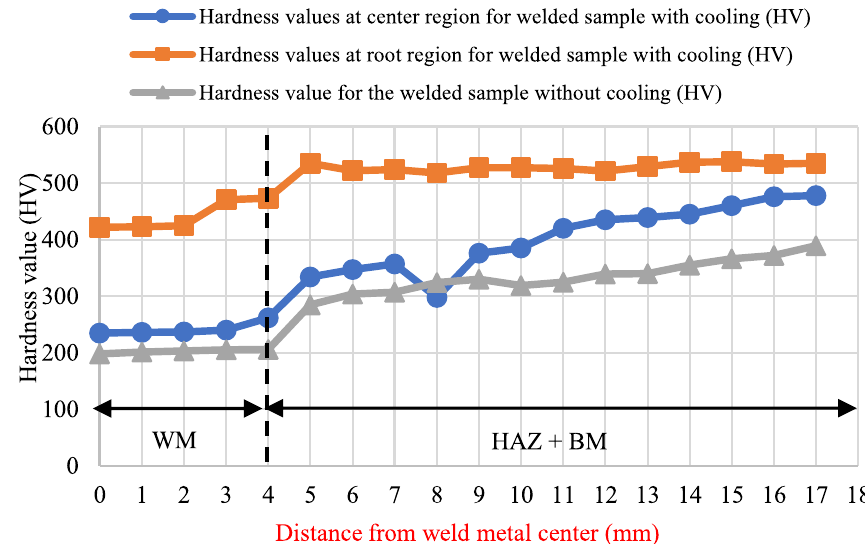
Table 14 and Fig. 18 show the hardness distribution of the joint welded using AWS A5.9 ER 307 filler wire and applying a single bevel groove joint. Without cooling, the hardness distribution at the mid-depth of the cross section of the specimen shows an increase in the hardness values that occurred in the HAZ with a sudden decrease in the hardness at the base metal region. Application of cooling resulted in the sig- nificant retainment of base metal hardness at a distance of 13 mm (455 HV) from the centerline of weld